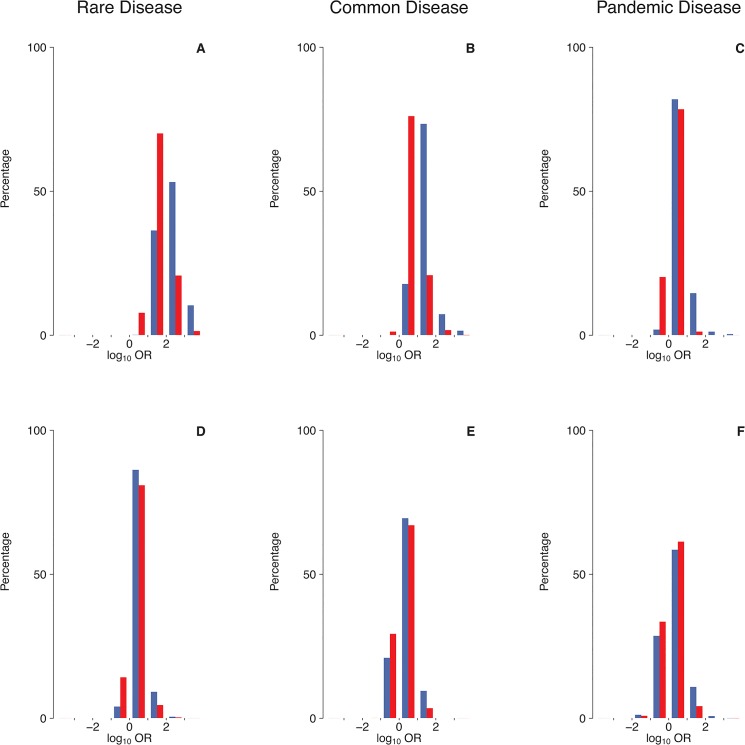
Epidemiological effect size of causative mutations at a single locus under two different penetrance models.The distribution of the log10 odds ratio (log10OR) is depicted for prevalence 0.1%-1.0% (A,D), 1%-5% (B,E) or 10%-20% (C,F), adopting either a multiplicative (A,B,C) or a logistic penetrance model (D,E,F). Blue: multiplicative model parameter γ = 0.3, logistic model parameters α = -5; β = 1; Red:γ = 0.1, α = -5; β = 0.5.